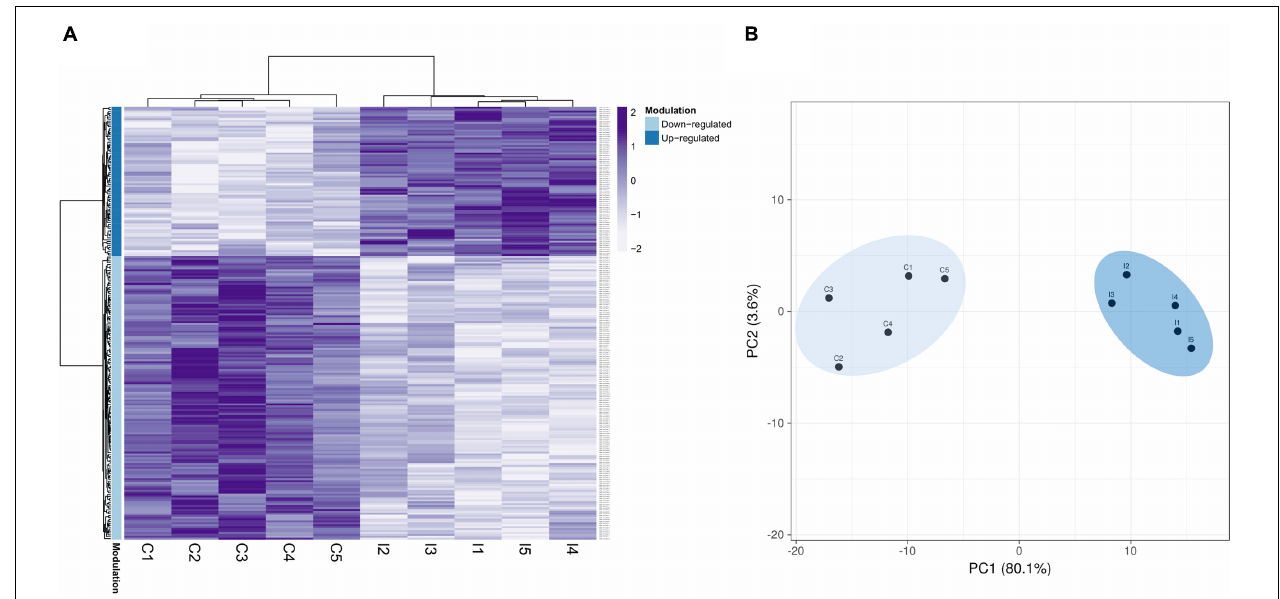
FIGURE 2 | Proteomic modulated response to a bacterial bath infection in mussel gills. (A) Heatmap showing the 226 differentially expressed protein DEPs ( q -value < 0.05). Upmodulated and downregulated proteins are indicated with different colors in the legend. (B) Principal component analysis (PCA) shows clear differences between the control (C1–5) and infected (I1–5) groups for these 226 DEPs.